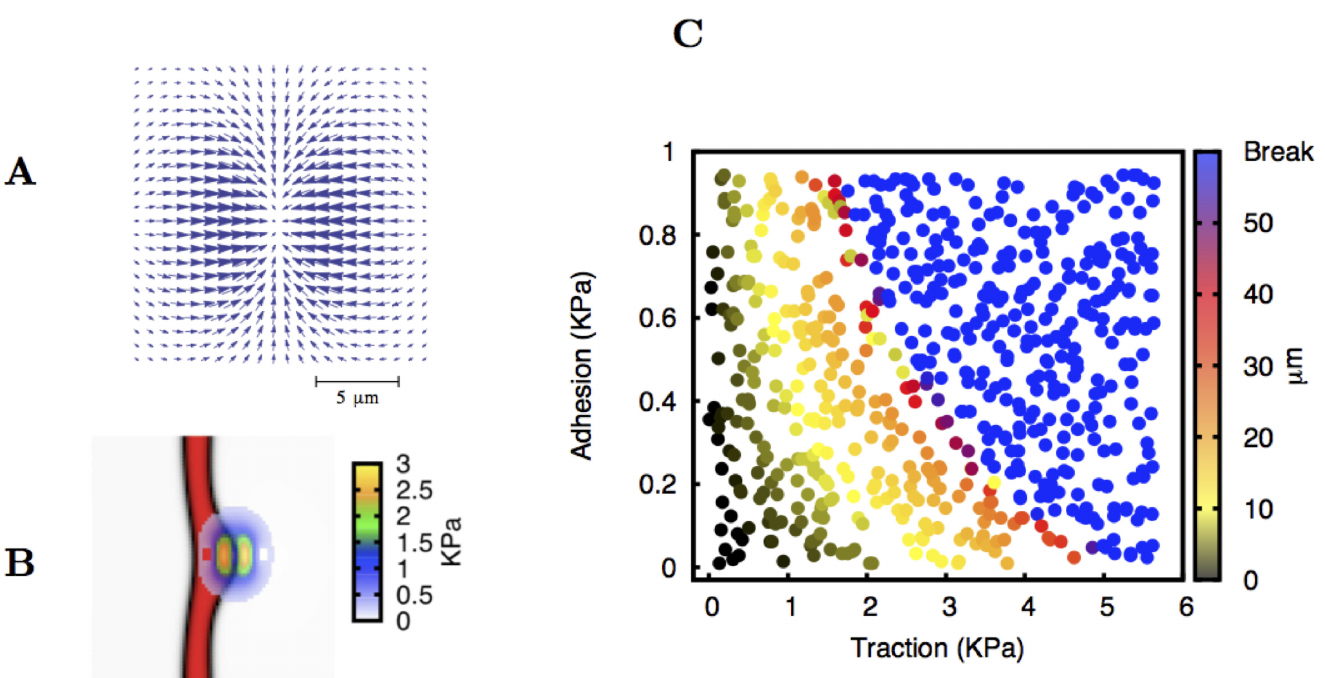
Fig 2. Formation of a single sprout without endothelial cell proliferation. Plate A: The contractile force field that is created by the tip cell is oriented along the direction of the VEGF gradient. Here we consider this force distribution, akin to the traction force field observed by in vitro experiments [20]. The typical size of the force region is the same as the size of an endothelial cell. Plate B: The centre of the force field is located at the border of the original vessel. In this figure a sprout is already forming. The local intensity of the traction force exerted by the tip cell is indicated. The maximum traction force in this case is 3.0 KPa. Plate C: Length of the sprout after 14.5 hours plotted as a function of the maximum tip cell traction force and adhesion coefficient. After that period of time we observe that the sprout almost does not increase its size. The values for adhesion and traction tested are chosen randomly within the studied interval. The length of the sprouts increases with the traction force applied. For large values of adhesion and traction force the tip cell pinches off.